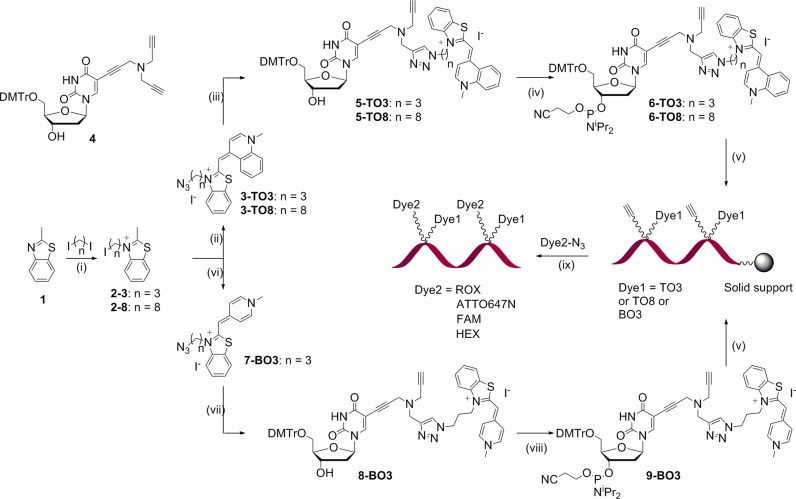
Synthesis of hybridization probes bearing an intercalating dye moiety and a free alkyne for coupling to azide-modified dyes. Conditions: (i) n = 3: MeCN, 105°C, 48 h, 64%; n = 8: MeCN, 150°C, 27 h, 67%; (ii) (a) MeCN, NaN3, H2O, RT, 19 h (n = 3, 55%; n = 8, 54%), (b) N-methylquinolinium iodide, CH2Cl2/MeOH 1:1, Et3N, 16 h (n = 3, 29%; n = 8, 25%); (iii) 4, DMF, H2O, TBTA, CuSO4.5H2O, sodium ascorbate, RT, 2 h (n = 3, 38%; n = 8, 29%); (iv) CH2Cl2, DIPEA, DMF, 2-cyanoethyl-N,N-diisopropyl chlorophosphoramidite, RT, 2 h (n = 3, 70%; n = 8, 66%); (v) solid phase oligonucleotide synthesis; (vi) (a) 4-chloro-1-methylpyridinium iodide, CH2Cl2/MeCN 1:1, Et3N, RT, 10 min, 10%, (b) LiN3, DMF, H2O, RT, 10 min, 76%; (vii) 4, DMF, H2O, TBTA, CuSO4.5H2O, sodium ascorbate, RT, 2 h, 26%; (viii) CH2Cl2, DIPEA, DMF, 2-cyanoethyl-N,N-diisopropyl chlorophosphoramidite, RT, 2 h, 64%; (ix) (a) THPTA, CuSO4.5H2O, sodium ascorbate, H2O, DMSO, 55°C, 4 h, (b) concentrated aqueous ammonia, RT, 4 h.